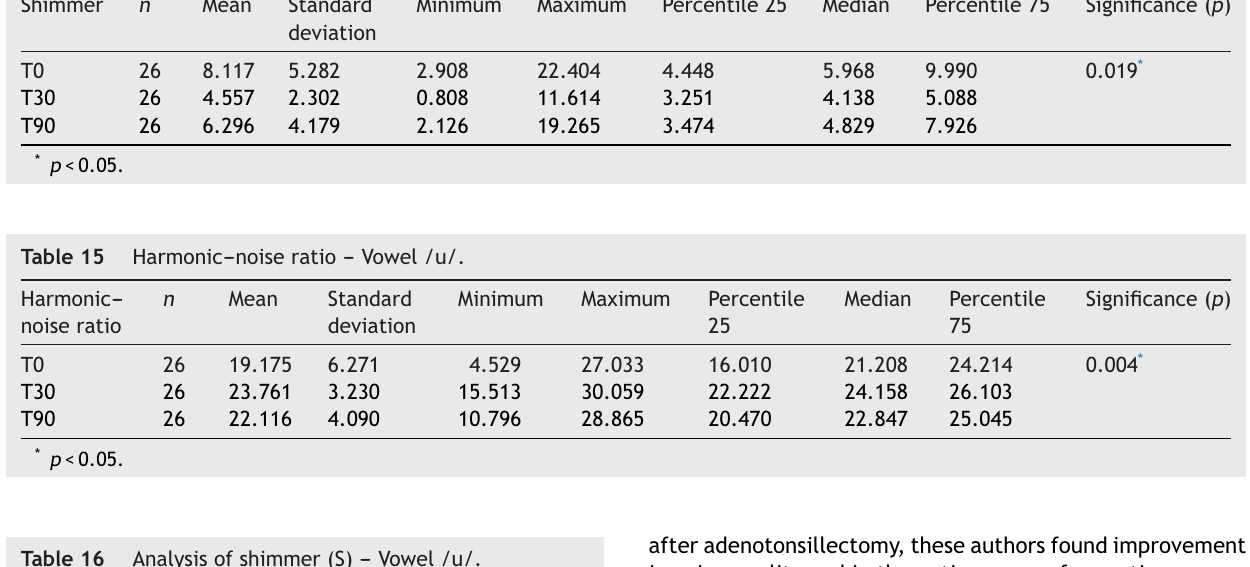
Shimmer --- Vowel /u/. Shimmer